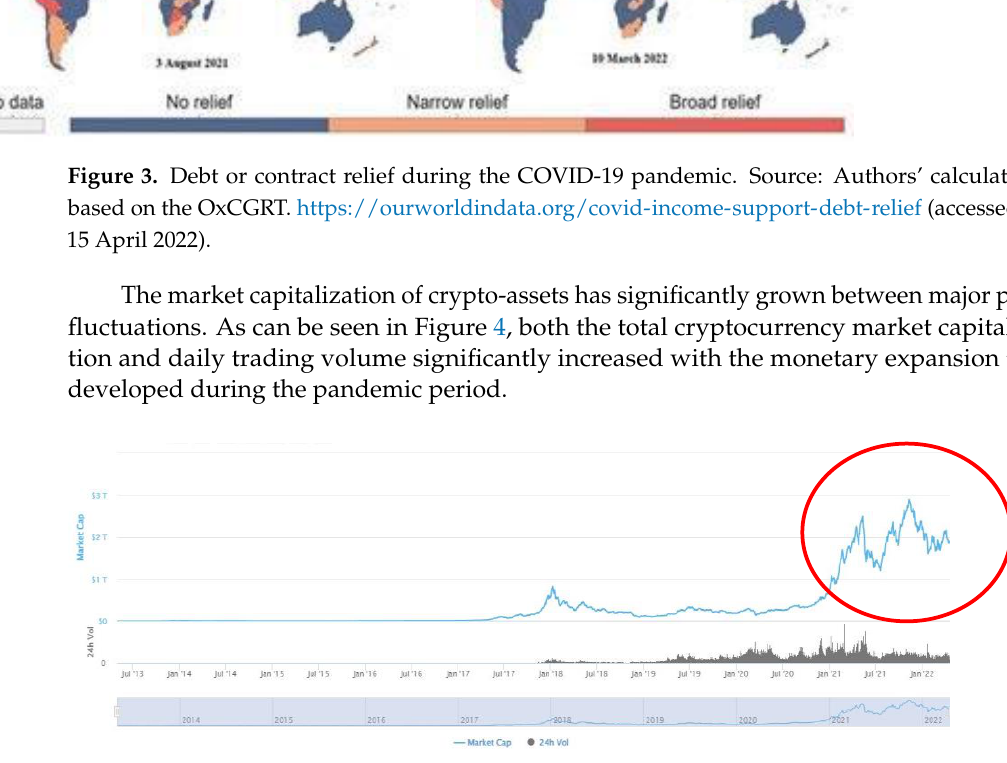
Figure 4. Total cryptocurrency market capitalization and 24th Volume. Source: https://coinmarketcap.com/charts/ (accessed on 20 April 2022).